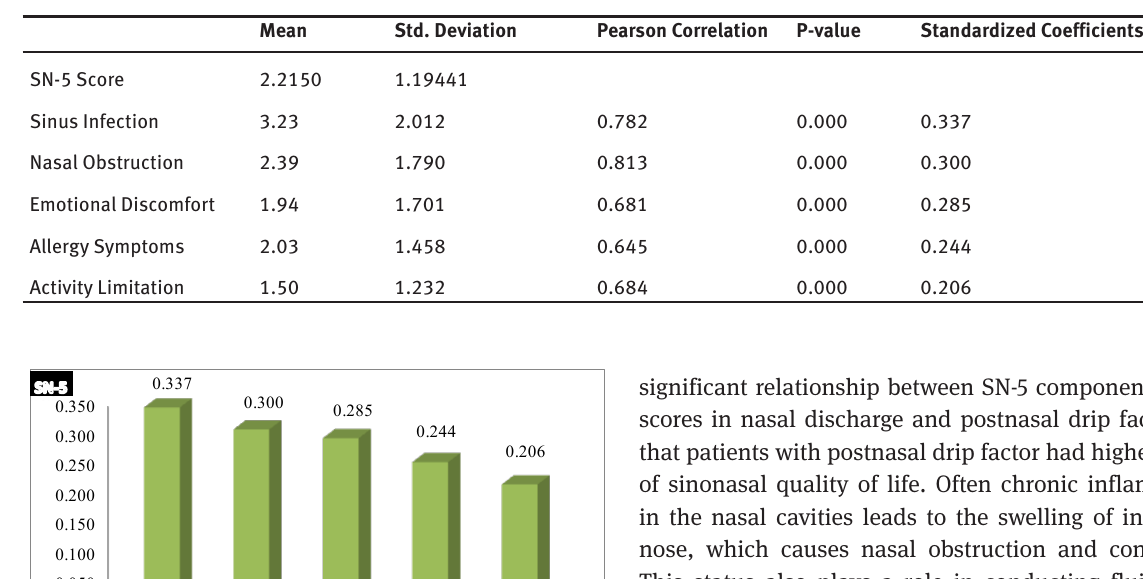
Table 6: Factor coefficient for determining SN-5 mean score.